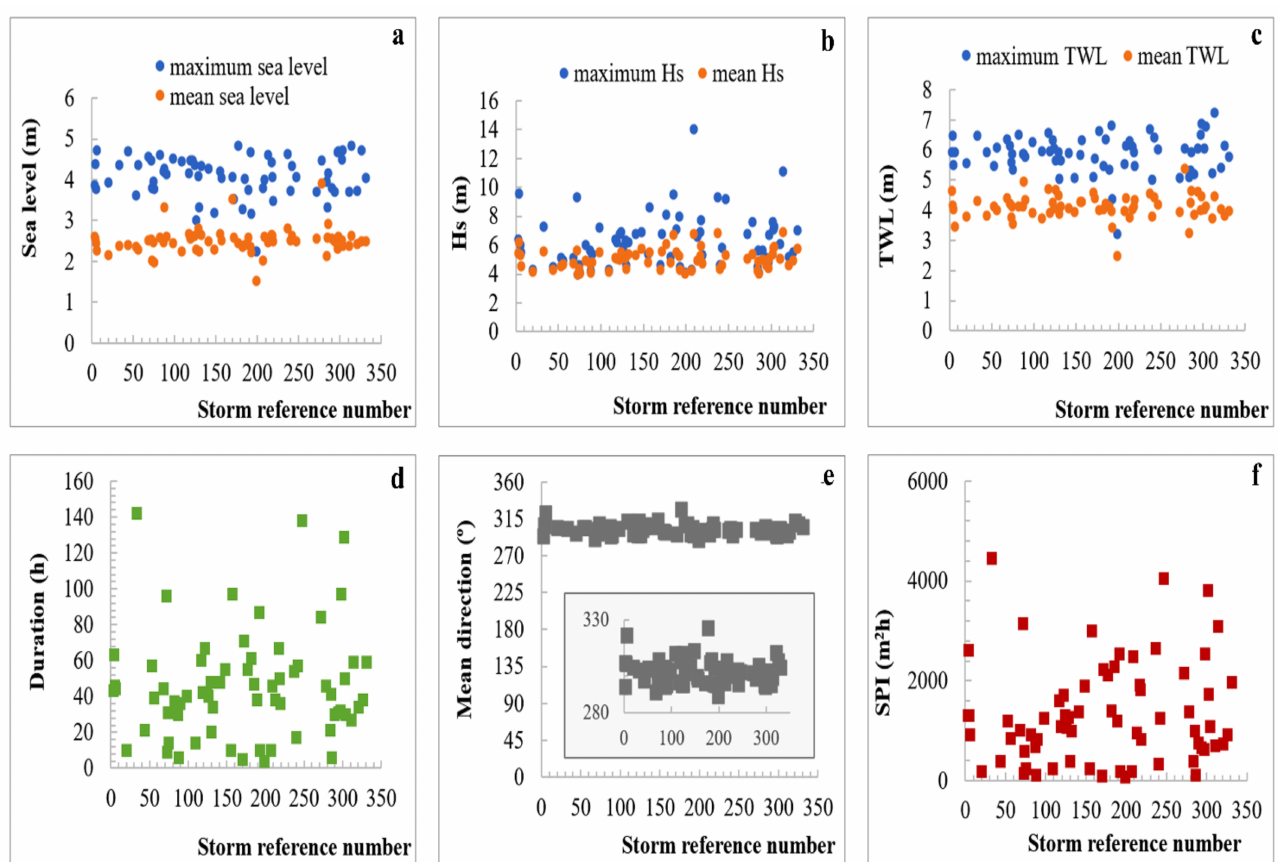
Figure 9. Values of the different hydrodynamic parameters for each damaging storm episode, in chronological order: ( a ) Sea level; ( b ) Wave height; ( c ) Total water level; ( d ) Duration (green); ( e ) Mean direction (grey); ( f ) Storm Power Index